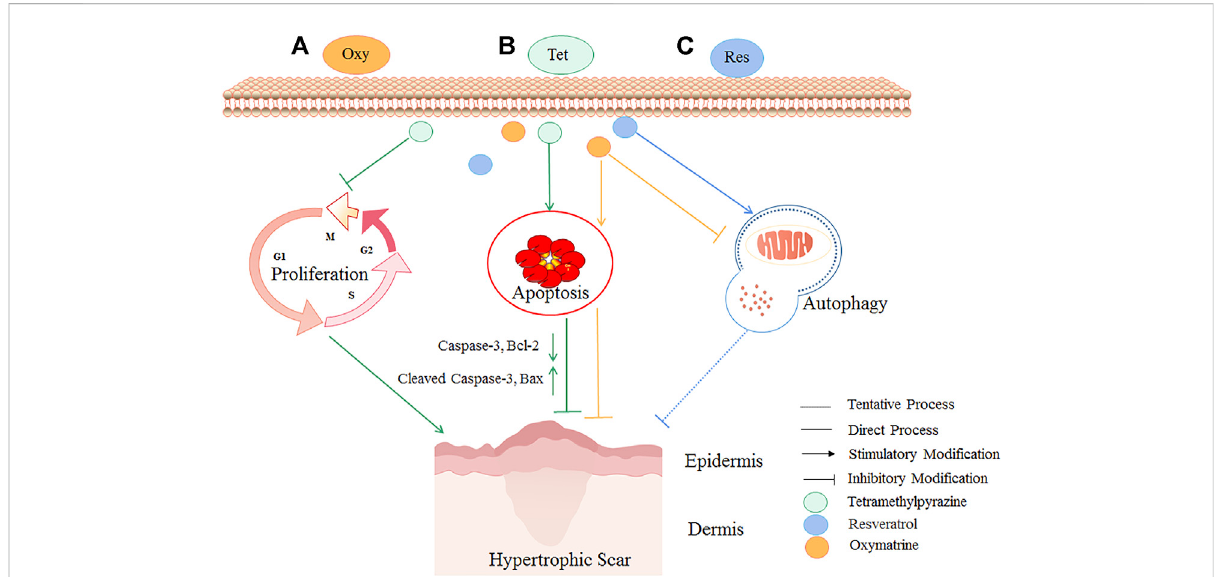
FIGURE 3 The HS inhibitory mechanism of TCM (oxymatrine, tetramethylpyrazine, and resveratrol) by inhibiting fi broblast proliferation and inducing fi broblasts ’ apoptosis and autophagy. Autophagy is a conserved catabolic pathway that maintains cell metabolism and homeostasis. However, excessively activated autophagy can lead to cell death. Oxymatrine (A) could reduce scar area and epidermal-dermal thickness potentially by inhibiting autophagy and inducing apoptosis. Tetramethylpyrazine (B) could attenuate HS by inhibiting the proliferation of scar fi broblasts, activating the expression of proapoptotic proteins Bax and Cleaved Caspase-3, and reducing Caspase-3 and Bcl-2. Resveratrol (C) could potentially treat HS by activating autophagy. The yellow lines are the cellular processes modulated by oxymatrine, the green lines are the cellular processes modulated by tetramethylpyrazine, and the blue lines are the cellular processes modulated by